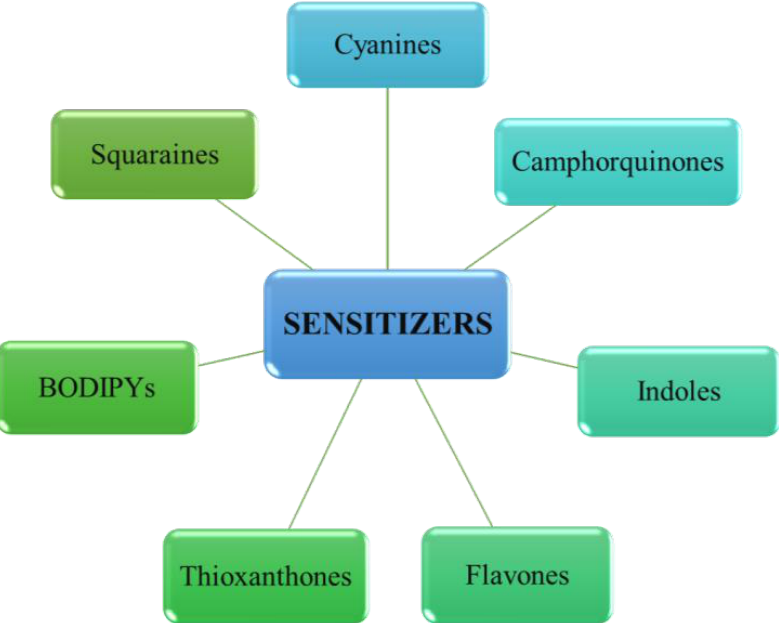
Figure 5. Popular sensitizers used in photoinitiating systems.